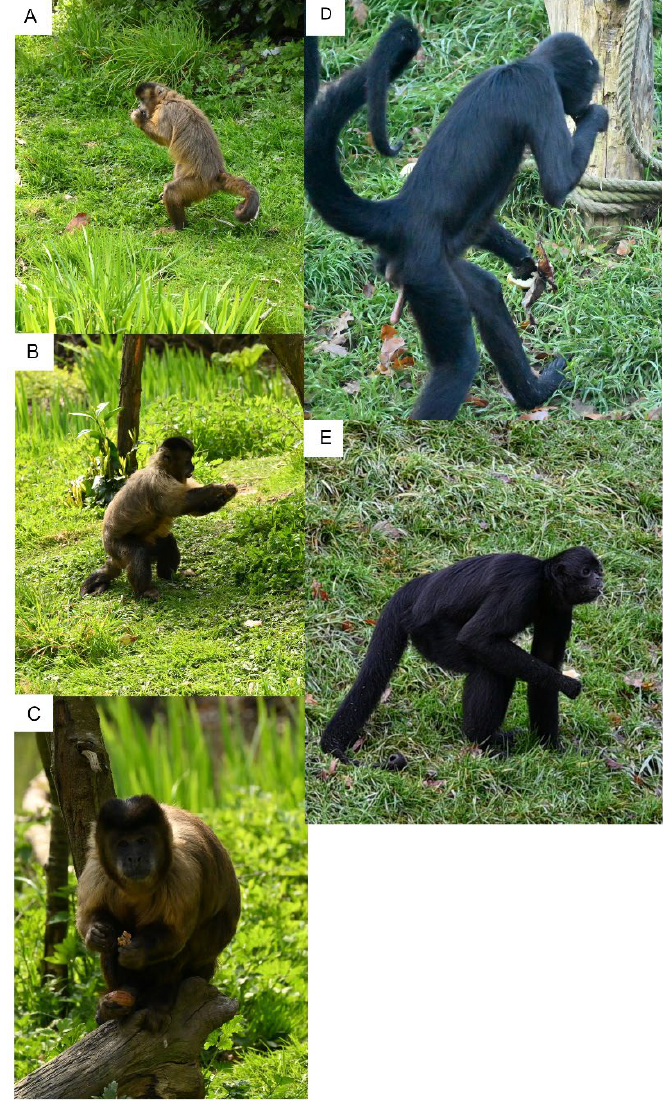
Figure 8. Various posture extracted at the end of body motor sequences during food transport and feeding by ( A – C ) Cebus capucinus , and ( D , E ) Ateles fusciceps rubiventris. ( A ) C. capucinus manipulating food and feeding in a bipedal posture. ( B ) C. capucinus manipulating food and feeding in a tripodal posture made by the two hindlimbs and the tail. ( C ) C. capucinus manipulating food and feeding in a “sitting” posture with food in the hindfoot (power grip). ( D ) A. fusciceps rubiventris feeding in a bipedal posture. ( E ) A. fusciceps rubiventris feeding in a tripodal posture made by the two hindlimbs and one forelimb. The structure of the limbs and the tail in both species influences the posture that the animals are able to use to handle food and feed.